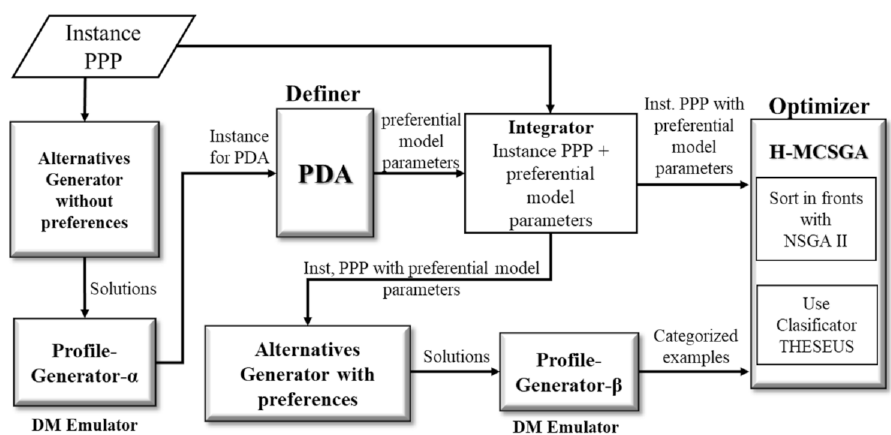
Figure 5. The Preference Hybrid Multi-Criteria Sorting Genetic Algorithm (P-HMCSGA) for incorpo- rating preferences in optimizers.